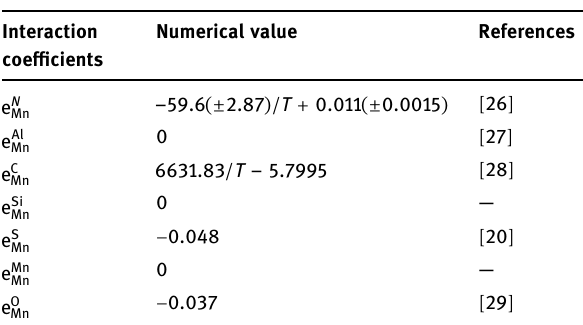
Table 4: Interaction coe ffi cients applicable to high manganese